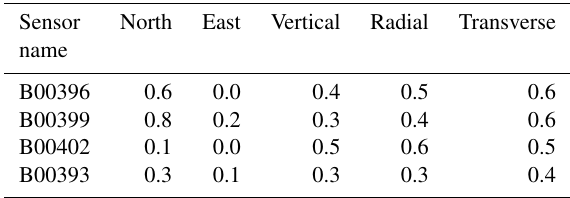
Figure 7. Acceleration time series from MEMS and HRGPS dis- placements in the Radial-Transverse coordinate system. The thick dashed lines represent displacement estimated using the HRGPS displacements of the Foligno (FOL1) permanent site. The thin solid lines show acceleration time series recorded at four differ- ent MEMS stations – the code of each instrument is reported. The MEMS signals of the four stations are arranged in decreasing order from top to bottom according to epicentral distances. The horizon- tal axis denotes seconds from the origin time of the main shock: 01:36:32UTC of 24 August 2016. The right vertical axis denotes GPS displacements, while accelerations refer to the left axis. (Built with the Generic Mapping Tool software GMT – Creative Com- mons Attribution 4.0 License.) Table 4. Absolute Correlation coefficients estimated comparing the double-integrated MEMS data and GPS displacements filtered time series. The values refer to the time interval between 30 and 40s after the origin time of the main shock